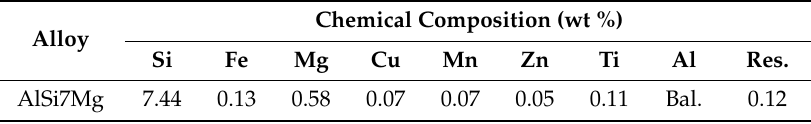
Table 2. Aluminum alloy chemical composition.